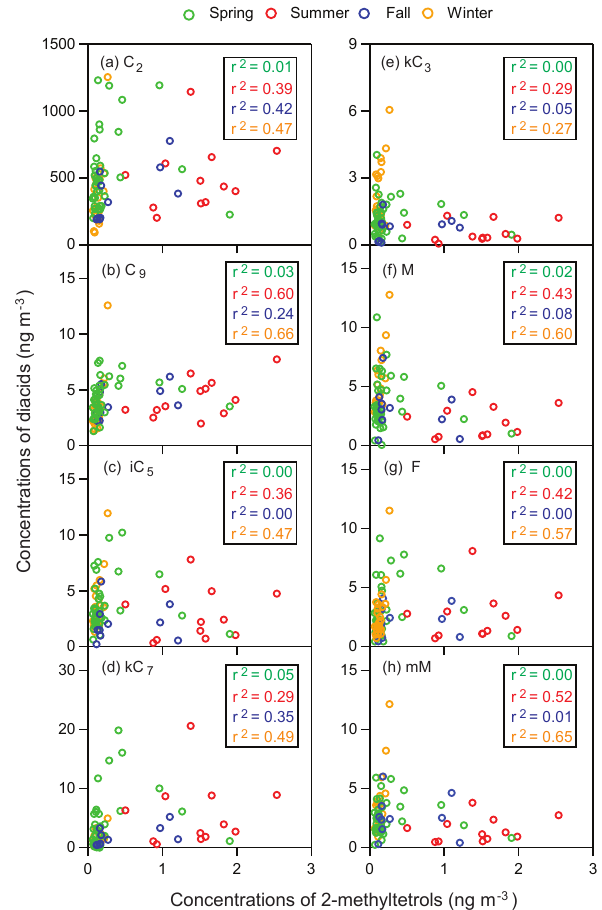
Figure 5. Correlations of 2-methyltetrols (SOA tracers of iso- prene) with saturated (a – e) and unsaturated (f – h) diacids in aerosol samples collected from April 2003 to April 2004: (a) oxalic (C 2 ) , (b) azelaic (C 9 ) , (c) methylsuccinic (iC 5 ) , (d) ketopimelic (kC 7 ) , (e) ketomalonic (kC 3 ) , (f) maleic (M), (g) fumaric (F) and (h) methylmaleic (mM) acids. Note that data have been grouped according to the